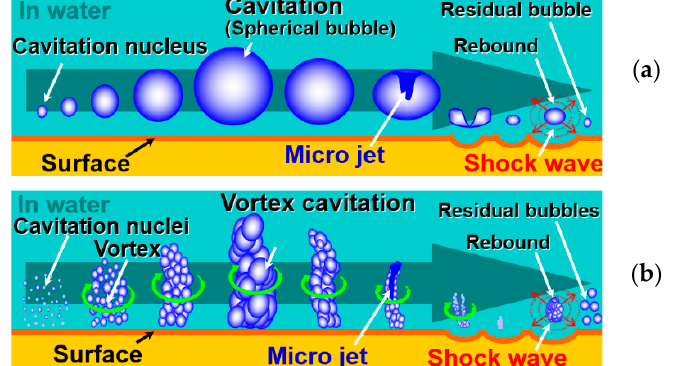
Figure 2. Schematic diagram of development and collapse of cavitation: ( a ) spherical bubble; ( b ) vortex cavitation.